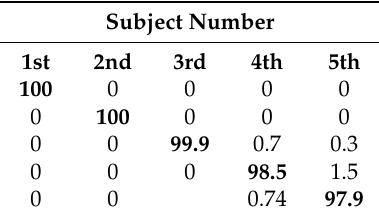
Table B1. The confusion matrix using DFA classifier after artifact removal for all N f = 34